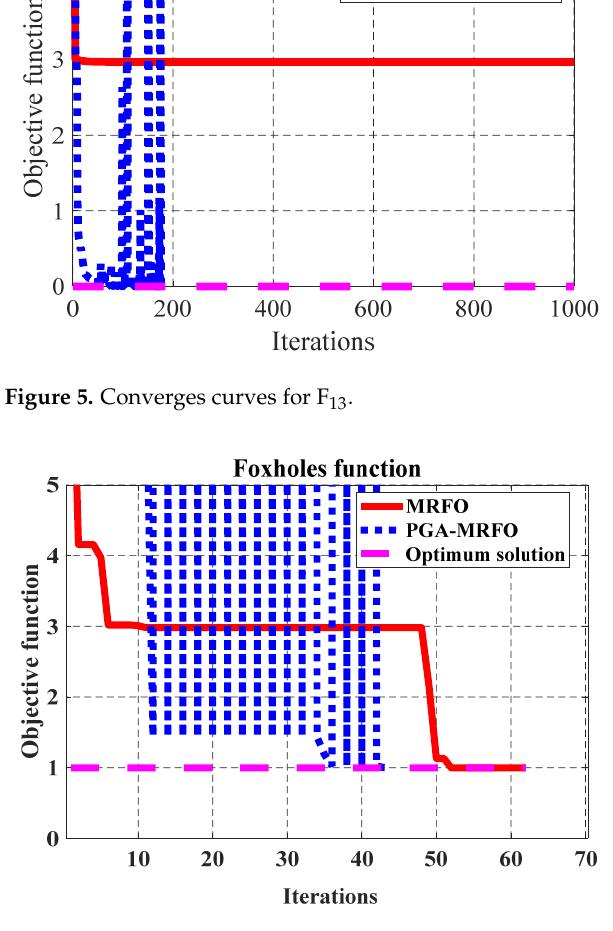
Figure 6. Converges curves for F 14 .